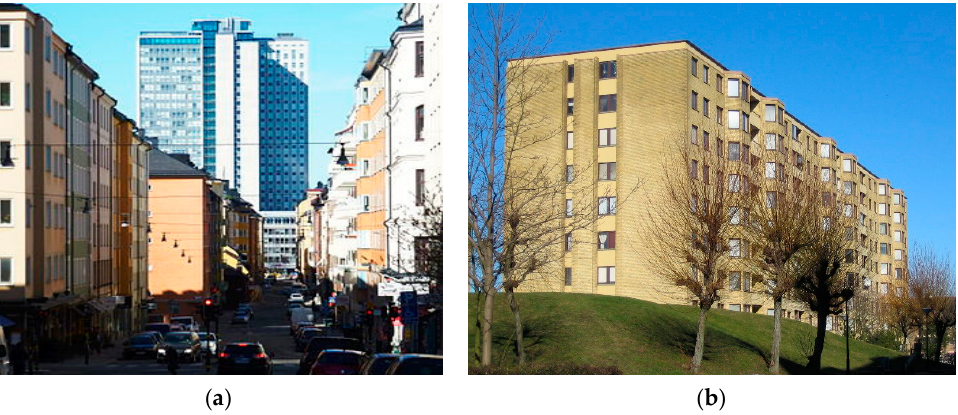
Figure 1. ( a) Dense urban landscape, with floor, walls and open roof. The public space is in shadow. ( b) Open urban landscape with vegetation as transparent curtains. Wandering light/shadow in the ( b ) Open urban landscape with vegetation as transparent curtains. Wandering light / shadow in the public space (Photos: PDM). public space (Photos: